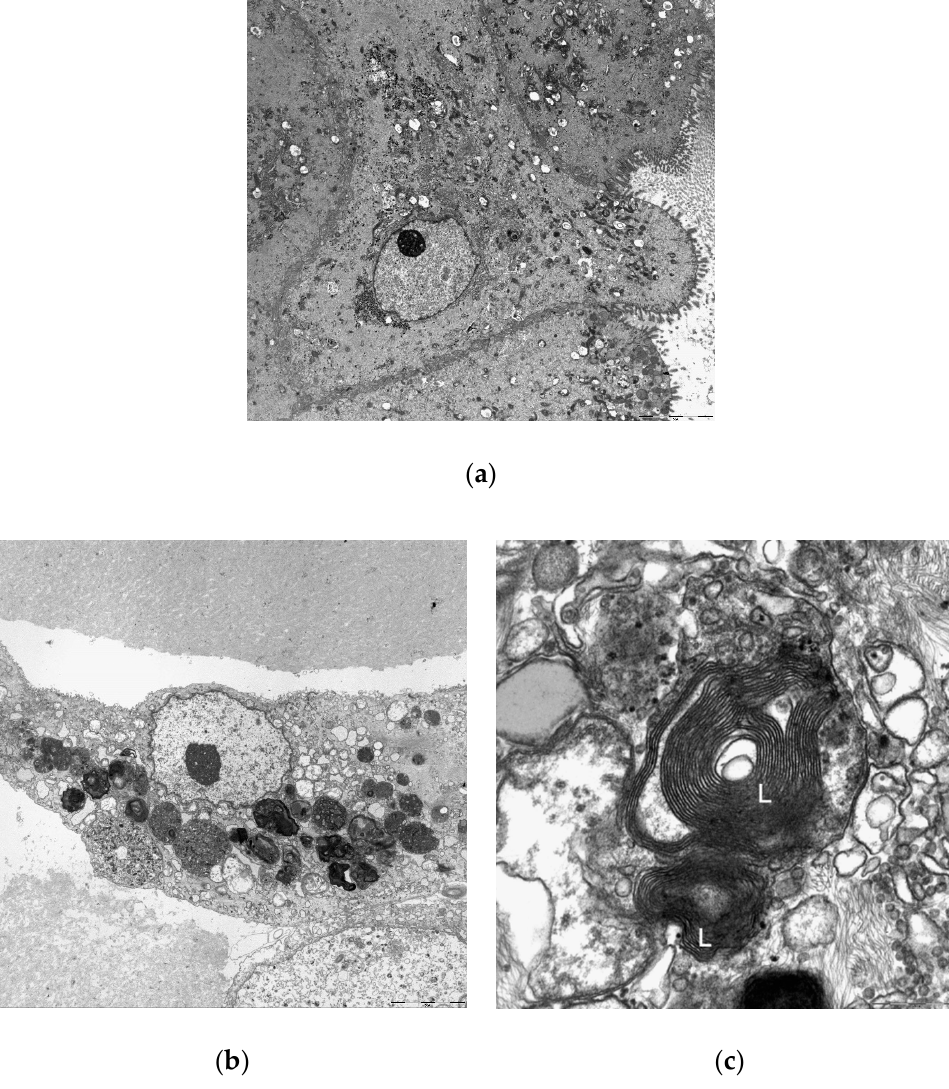
Figure 9. Transmission electron microscopic evaluation of the organoids, which had been differentiated for 12 days and then treated as follows: ( a ) Control (untreated); ( b, c ) 10 μ M amiodarone incubation for 48 h. Lamellar bodies are indicated by ‘L’. Original magnifications, ×3000 ( a, b ) and × 40,000 ( c ).